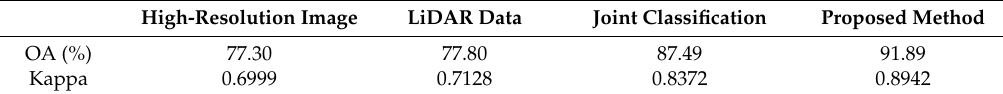
Table 2. Quantitative assessment of classification maps for the proposed method and the comparison methods. The reference is shown as Figure 15. The values in the table indicate the overall accuracy and Kappa coefficient.